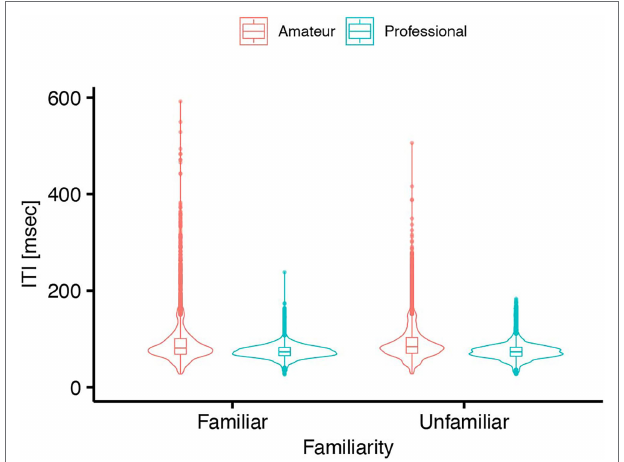
FIGURE 5 | Inter-tap interval of professional and amateur darbuka players under familiar (Li-Lr, Lr-Rr and Li-Rr) and unfamiliar (Ri-Rr, Li-Ri, and Lr-Ri) conditions in the double-finger tapping task ( n = 8 for the professional group and n = 8 for the amateur